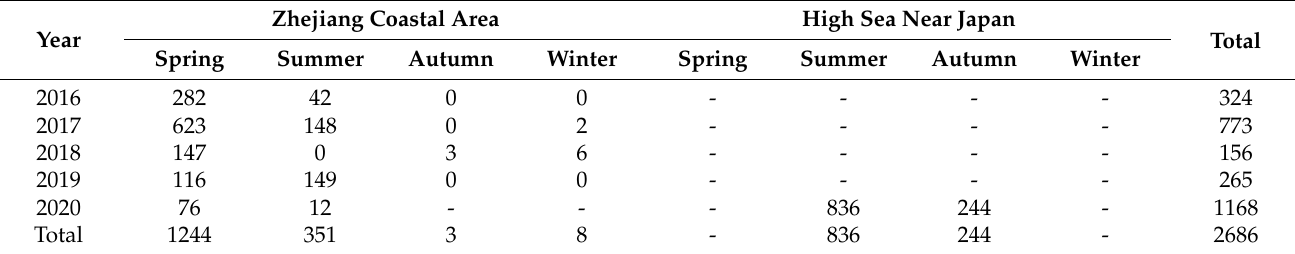
Table 1. The sample size of Chub mackerel for different years, seasons, and regions off the northwest Pacific